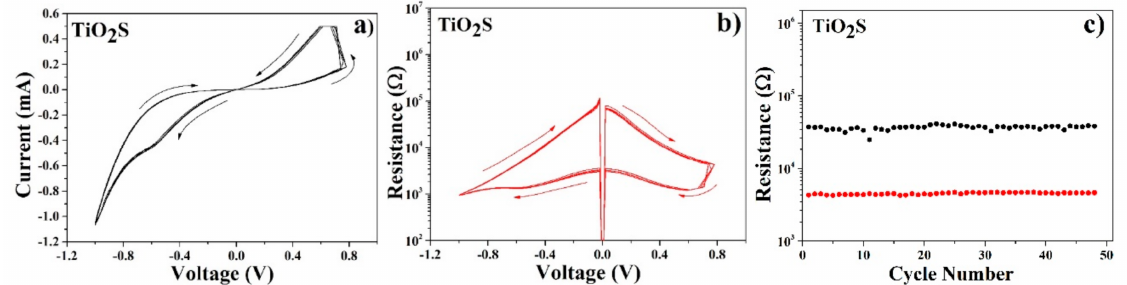
Figure 5. Typical electrical characteristics of TiO 2 S device, having Pt discs as a top electrode. I-V ( a ), R-V ( b ) curves together with device life ( c ; R OFF black dots, R ON red dots).